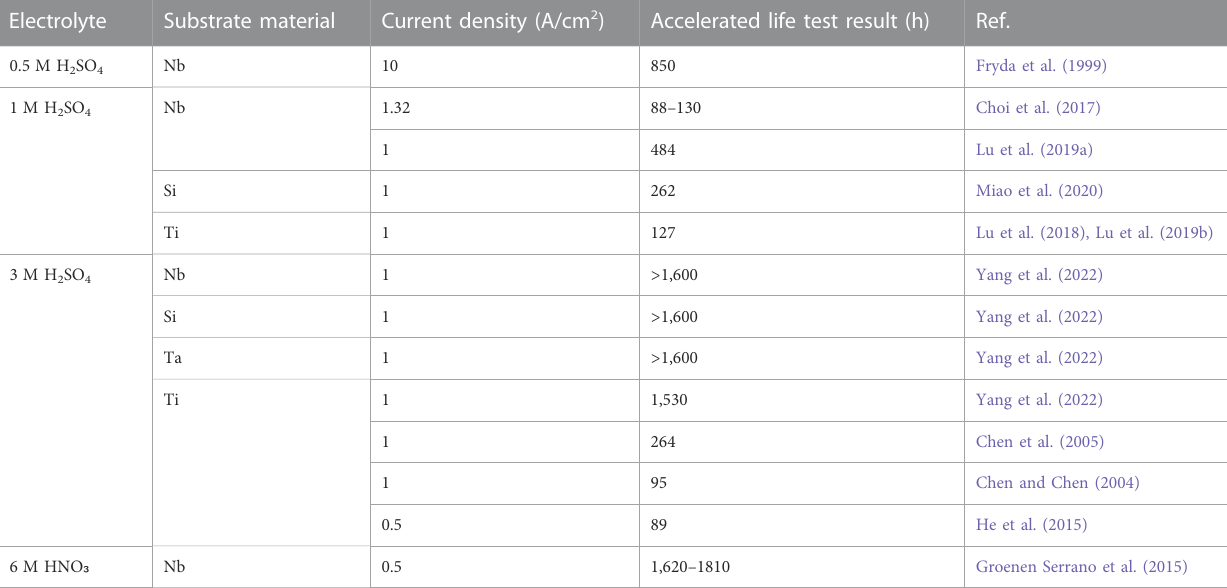
TABLE 3 Accelerated life test results and experimental conditions found for several studied BDD electrodes.